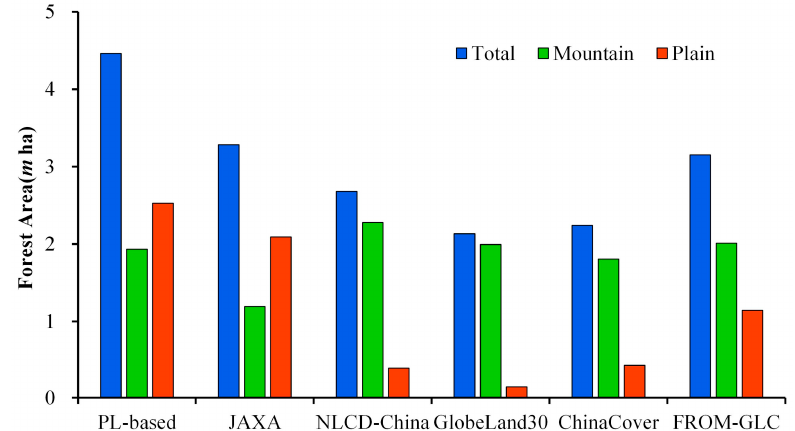
Figure 7. Forest area in the study area according to the six satellite-based forest maps in 2010.